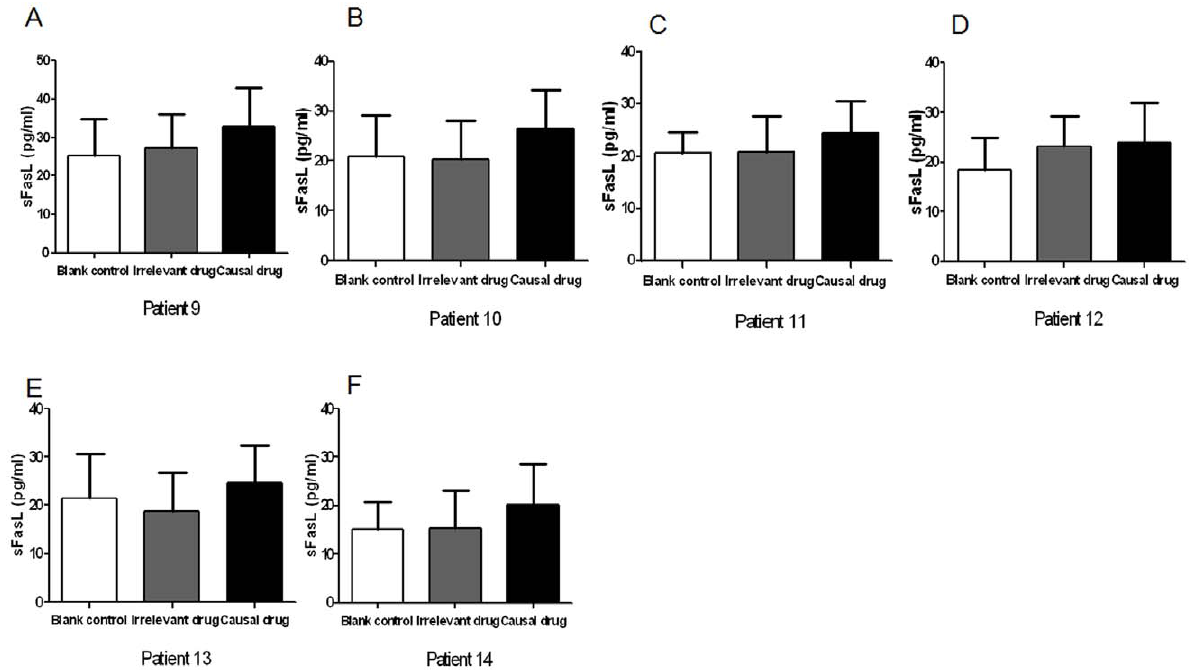
Figure 5. sFasL levels in supernatant of drug-stimulated PBMCs from MPE patients. PBMCs from patients with MPE were cultured with causal drugs, irrelevant drugs, or medium alone for 3 days. The supernatants were collected and the concentrations of sFasL were determined by sFasL ELISA kit. A–F, Patient 9–14. The graphs show the means of three samples of each patient and error bars represent SD values.